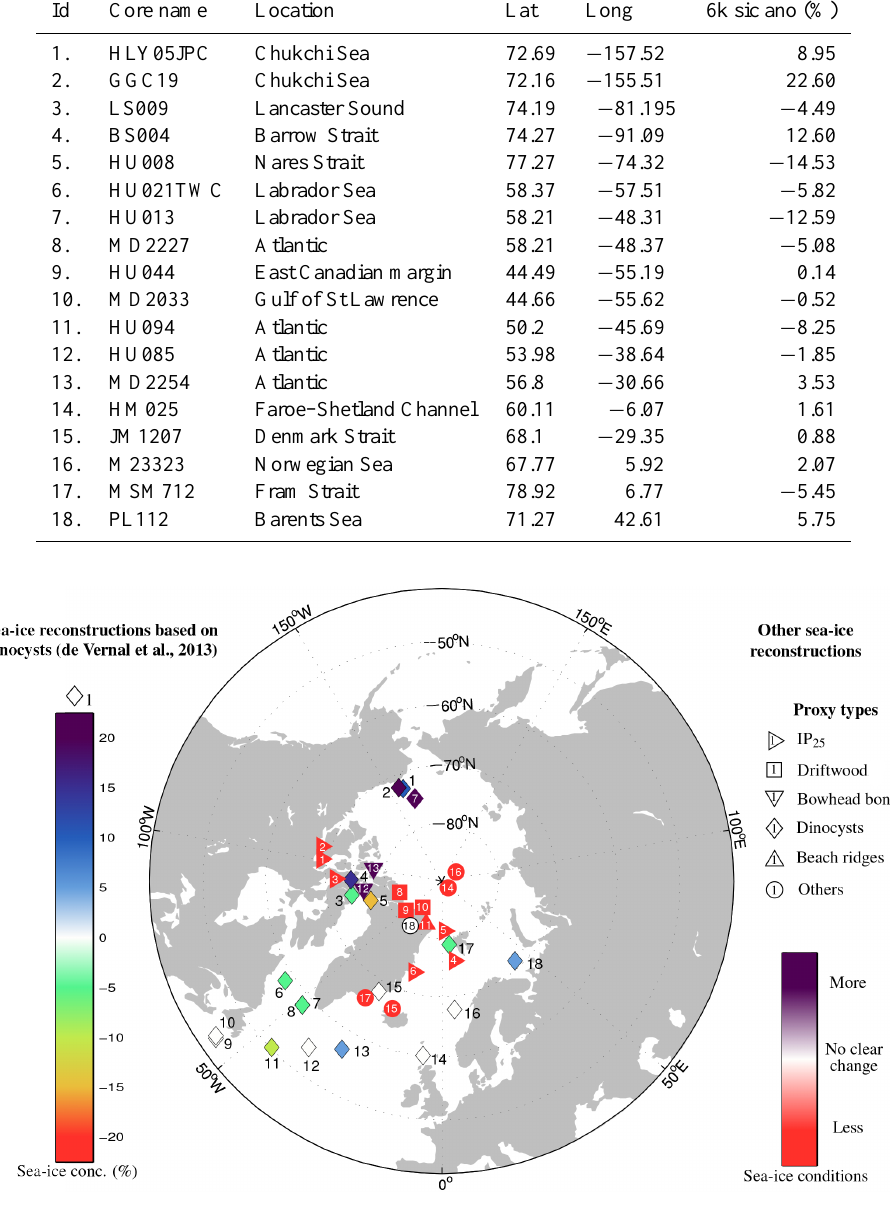
Figure 1. Reconstructions of sea ice conditions for the mid-Holocene. Diamonds markers with number next to them (refer to the left- hand coloured bar) correspond to MH sea ice concentration anomalies (in %) using the reference period AD1850–1900 based on dinocyst assemblages (de Vernal et al., 2013a). The other markers with numbers inside are the MH sea ice signals derived from different sea ice proxies (see key on the right). Sea ice conditions are expressed in terms of more (blue) or less (red) sea ice in the MH as compared to a reference period which varies depending on the record but which generally covers most of the Holocene (see Table 3). The location of some proxies has been shifted slightly for an improved